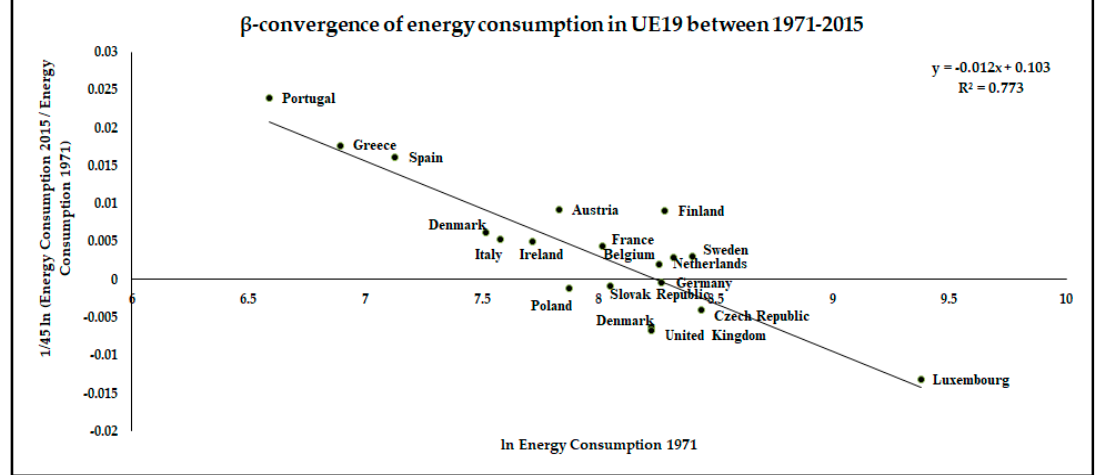
Figure 2. β -convergence of energy consumption in UE19 1971–2015 (Model 2).